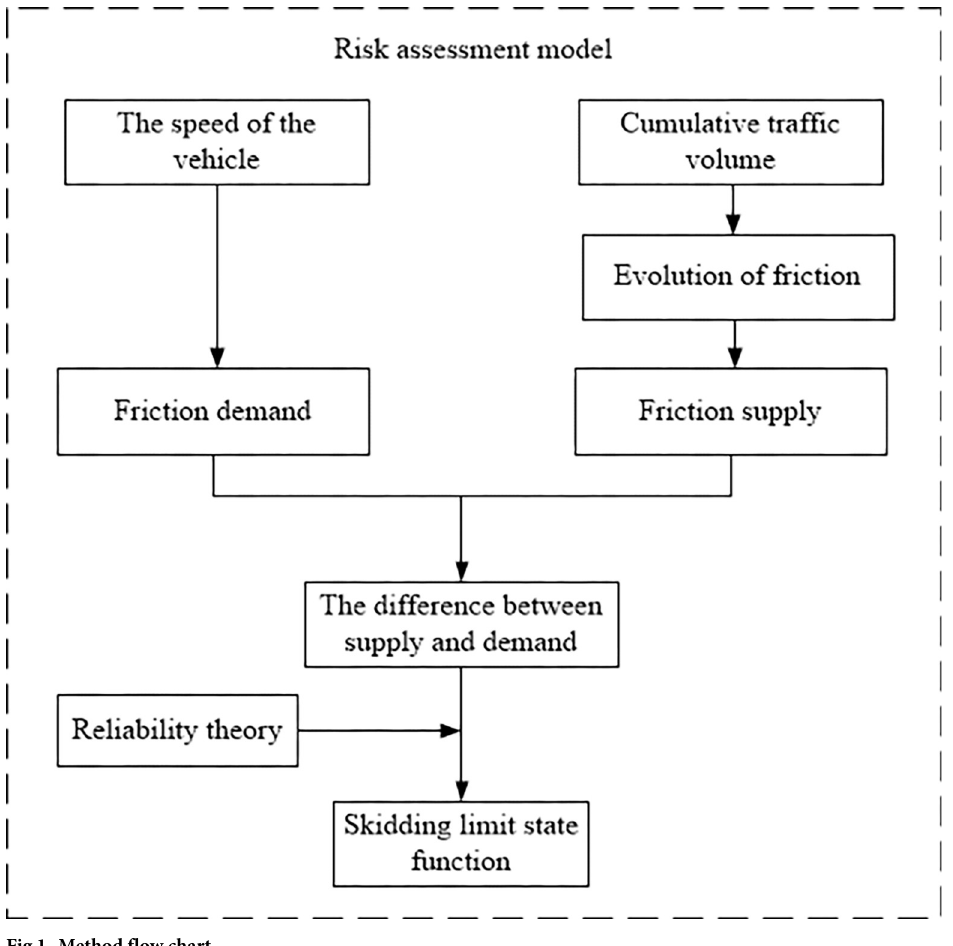
Fig 1. Method flow